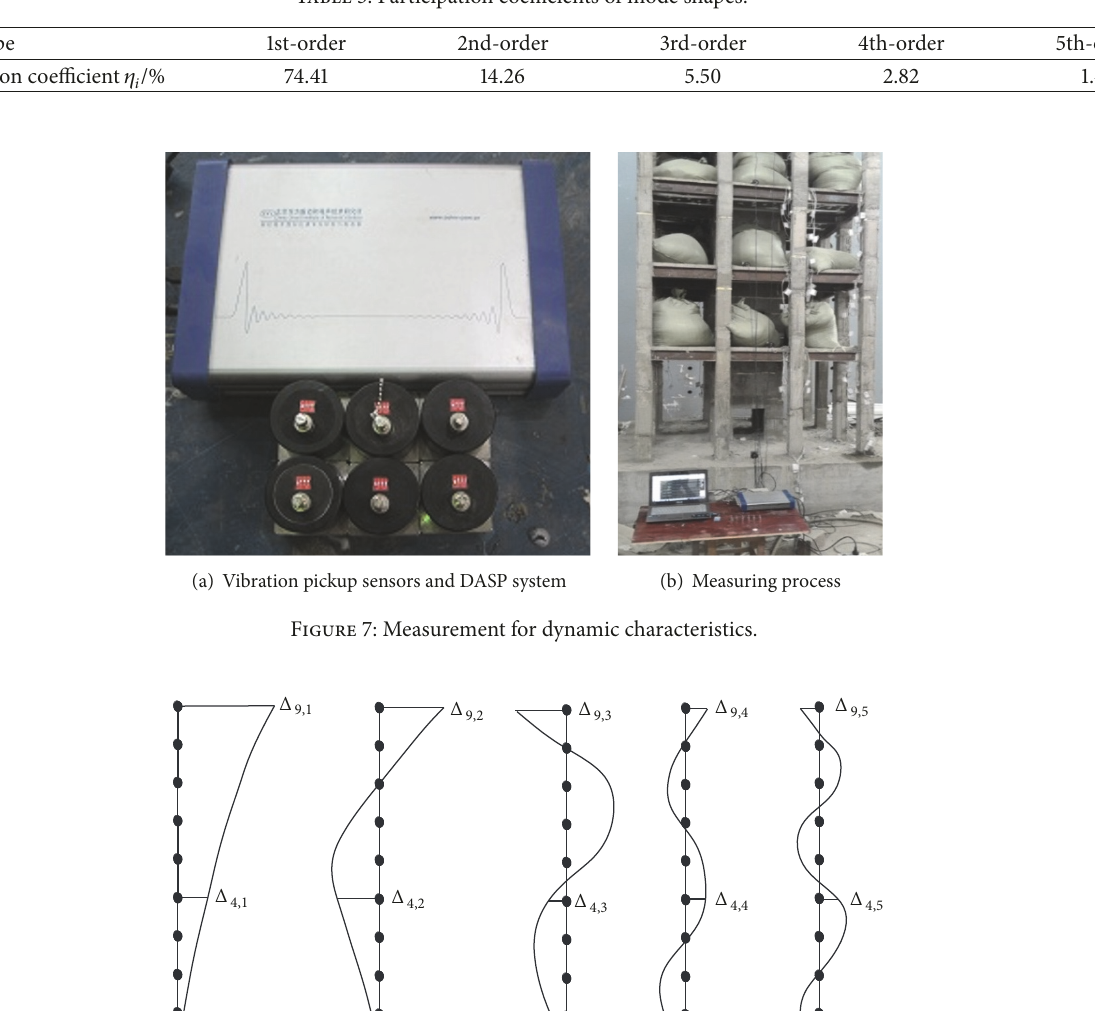
Table 3: Participation coefficients of mode shapes.